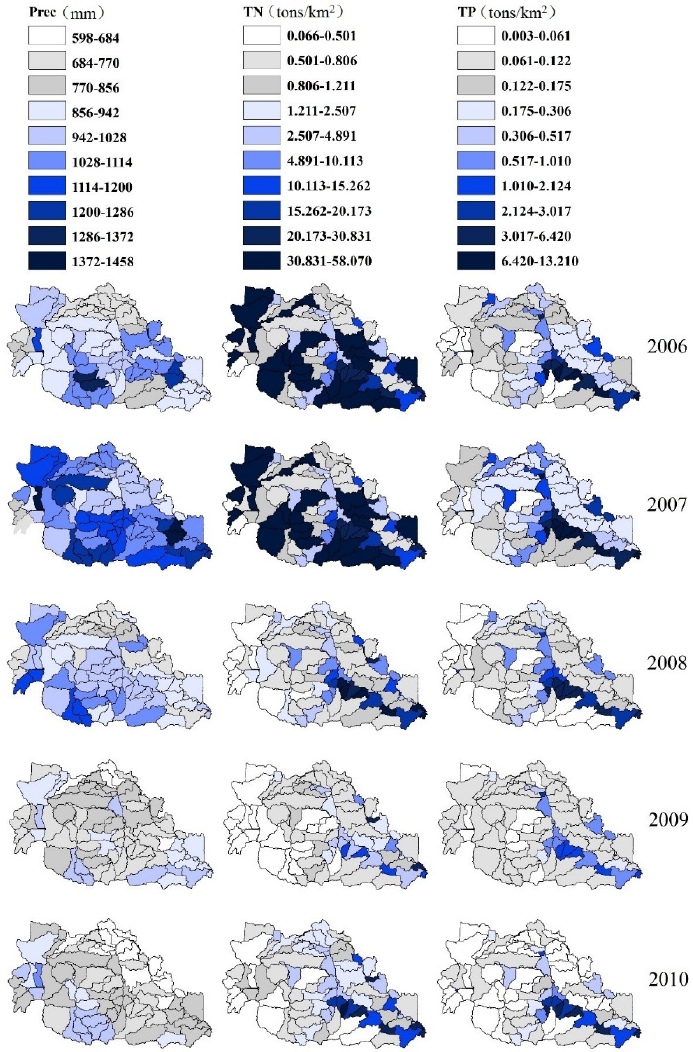
Figure 6. Spatial distribution of TN and TP load annual yields from 2006 to 2010.